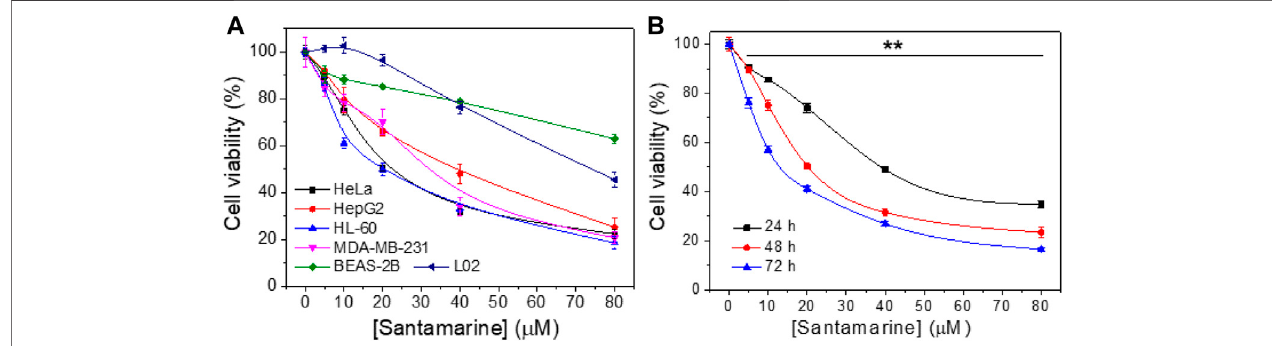
FIGURE 2 | Santamarine harbors cancer-selective antiproliferative activity. (A) Cell viability of cancer cell lines (HeLa, HepG2, HL-60, and MDA-MB-231) and noncancerous cell lines (BEAS-2B and L02) after treatment with santamarine. The viability was detected by the MTT assay after cells were incubated with increasing concentrations of santamarine for 48 h (B) HeLa cell viability assays in 24, 48, and 72 h were carried out as in (A) , with a range of concentrations of santamarine. The results of each cell line were normalized to untreated controls. ( n (cid:2) 3 biological replicates, data are mean ± s. d. ** p < 0.01 vs. the BEAS-2B group in (A) , and the control group in (B)